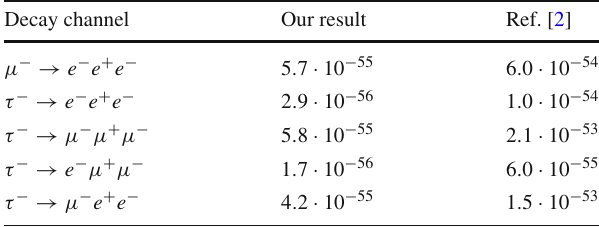
Table 1 Penguin contributions taking into account the constants in the Thompson limit Decay channel